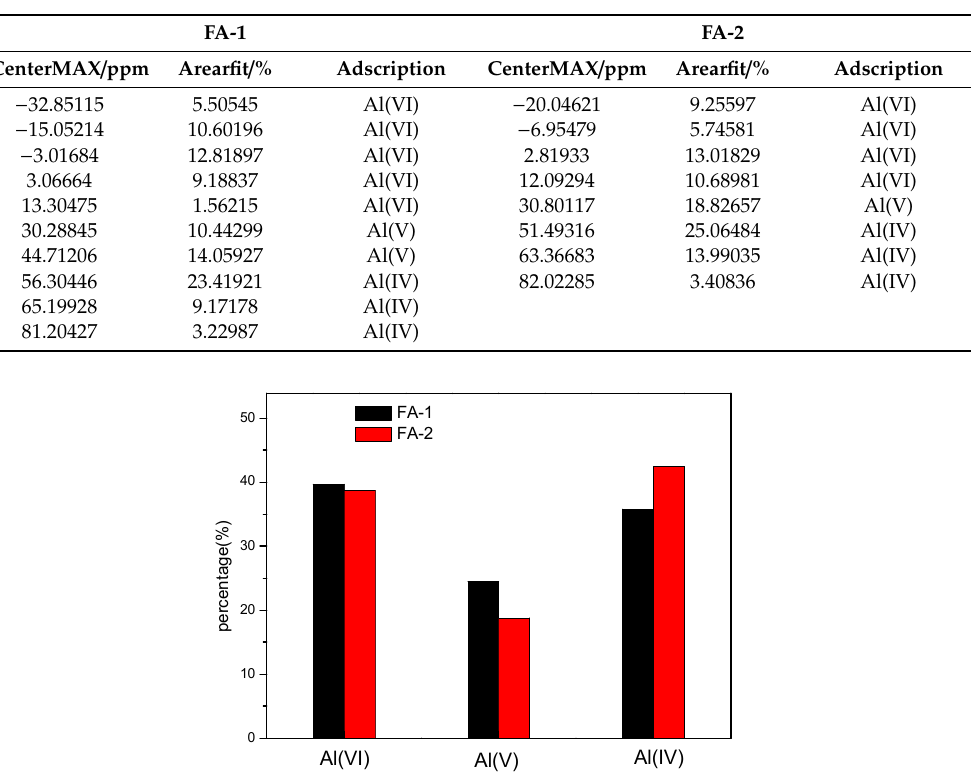
Figure 10. Comparison of the aluminium compositions for FA–1 and FA–2.